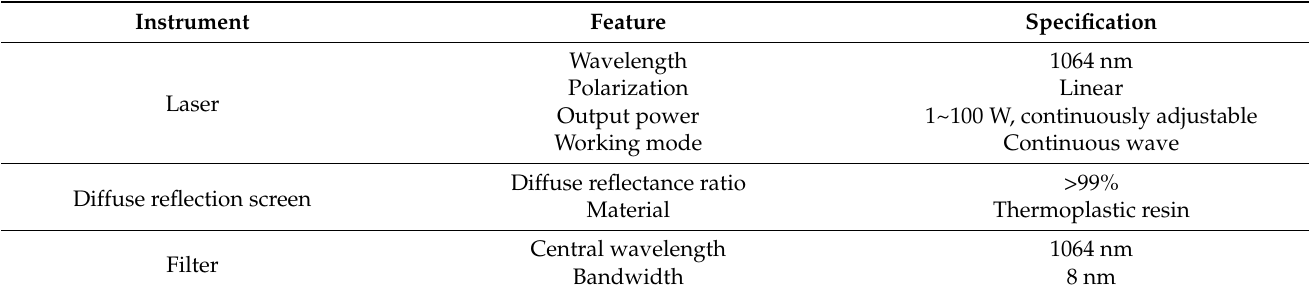
Table 1. Experiment instrument